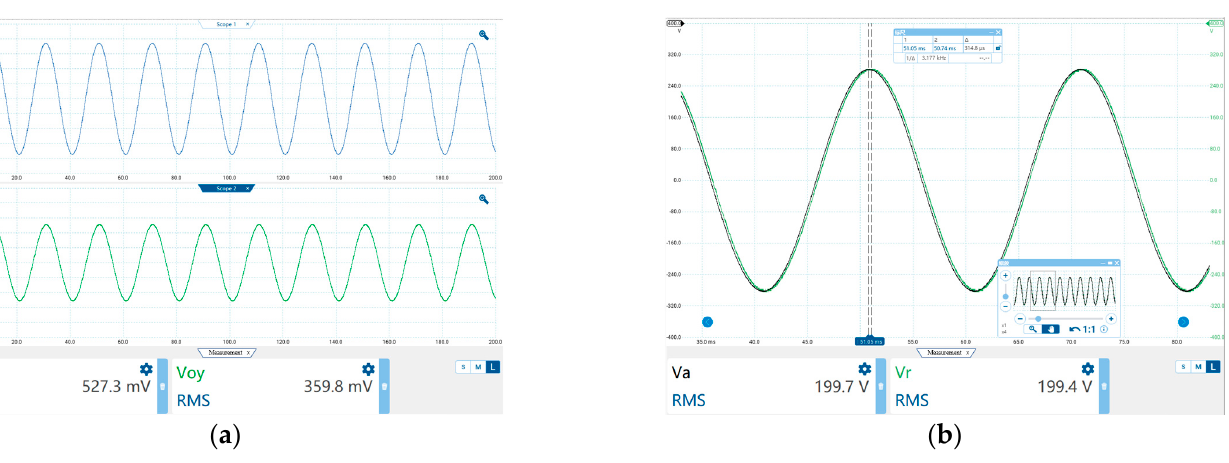
Figure 8. ( a ) When the actual voltage is 200 V rms , the sensor output before and after the sensor capacitance conversion. ( b ) Comparison between reconstructed voltage and actual voltage.